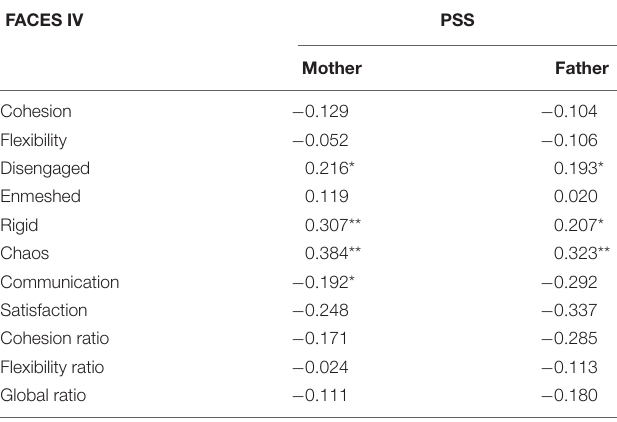
TABLE 3 | Pearson correlation between family adaptability and cohesion evaluation scale-IV (FACES-IV) scales and perceived stress scale (PSS) in the whole